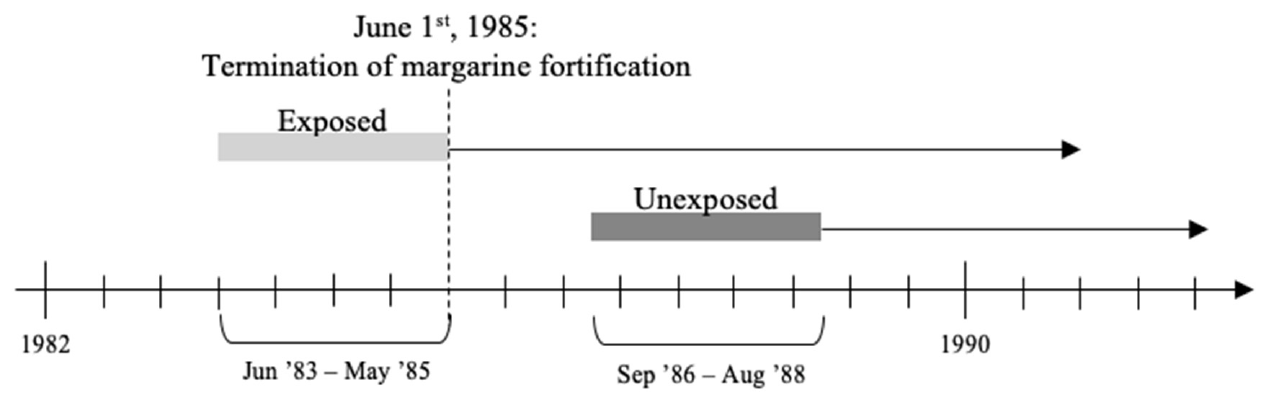
Figure 1. Illustration of study design.